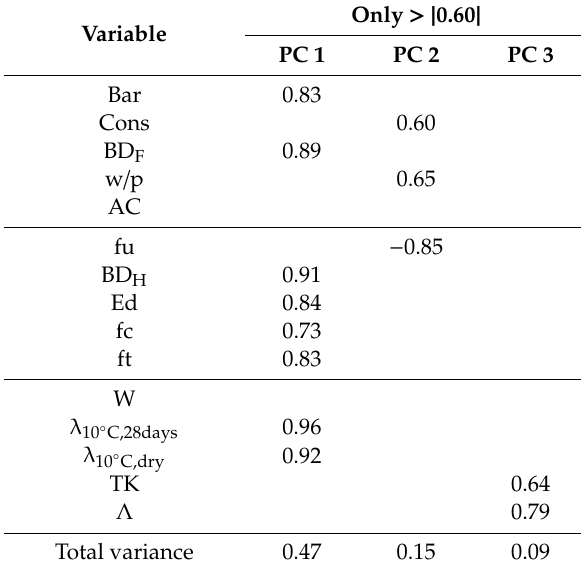
Table 8. Loadings for three components, considering Varimax rotation